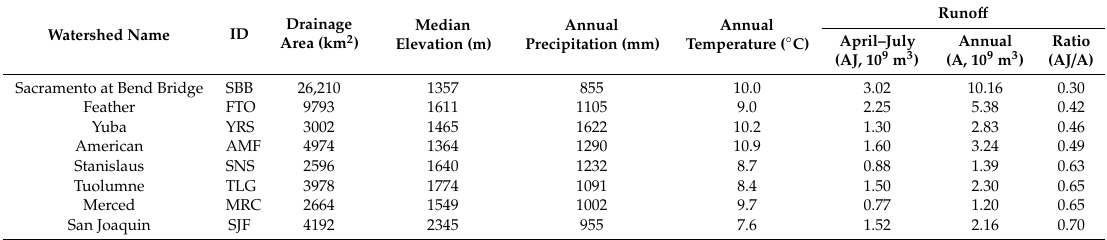
Table 1. Geographic and hydro-climatic characteristics of study watersheds 1 .